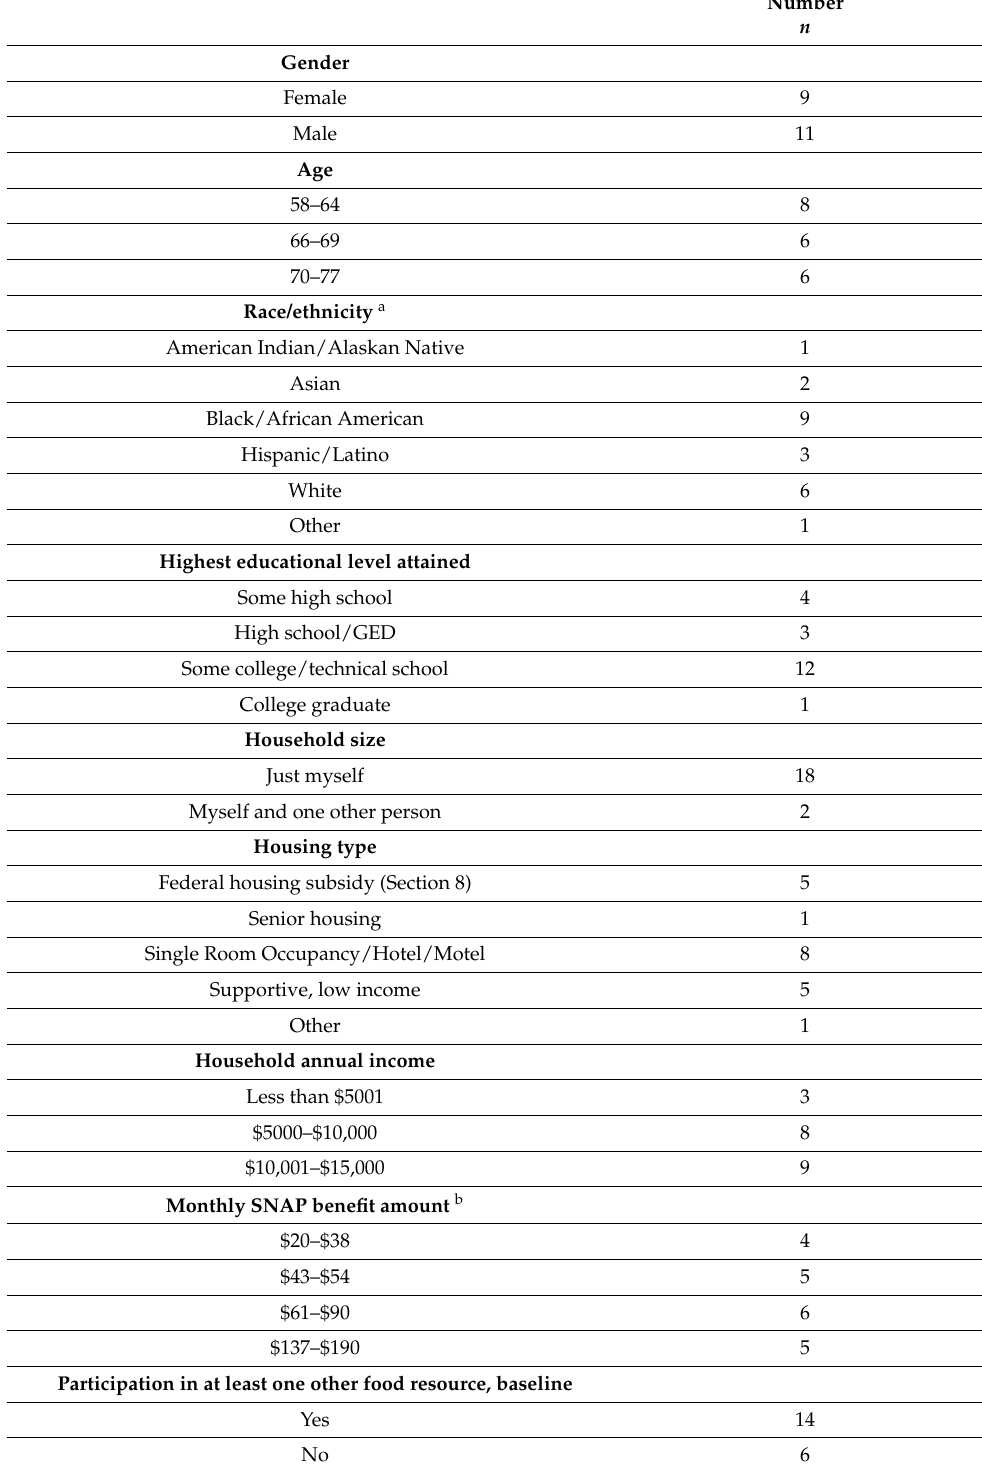
Table 1. Characteristics of a cohort of 20 older adult SSI recipients in California who participated in in-depth interviews on the impacts of SNAP after recent benefit